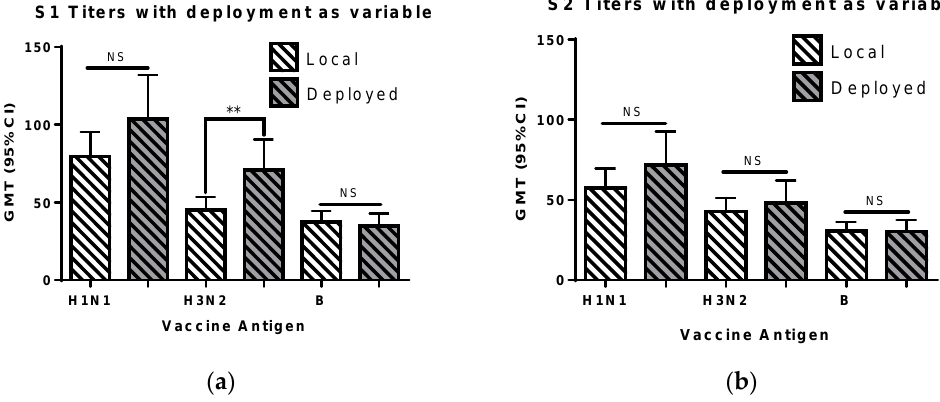
Figure 4. The geometric mean titers (with confidence interval) with deployment as a variable is shown for the S1 and S2 blood draws. The viruses used for testing HI titer for 2003 cohort subjects were A/New Caledonia/20/1999 (H1N1), A/Moscow/10/1999 (H3N2), and B/Hong Kong/330/2001 (Victoria lineage). The viruses used for testing HI titer for 2003 cohort subjects were A/California/07/2009 (pdmH1N1), A/Perth/16/2009 (H3N2), and B/Brisbane/60/2008 (Victoria lineage). The difference between the two groups was evaluated using the Mann Whitney rank test. NS, not significant; and **, p <